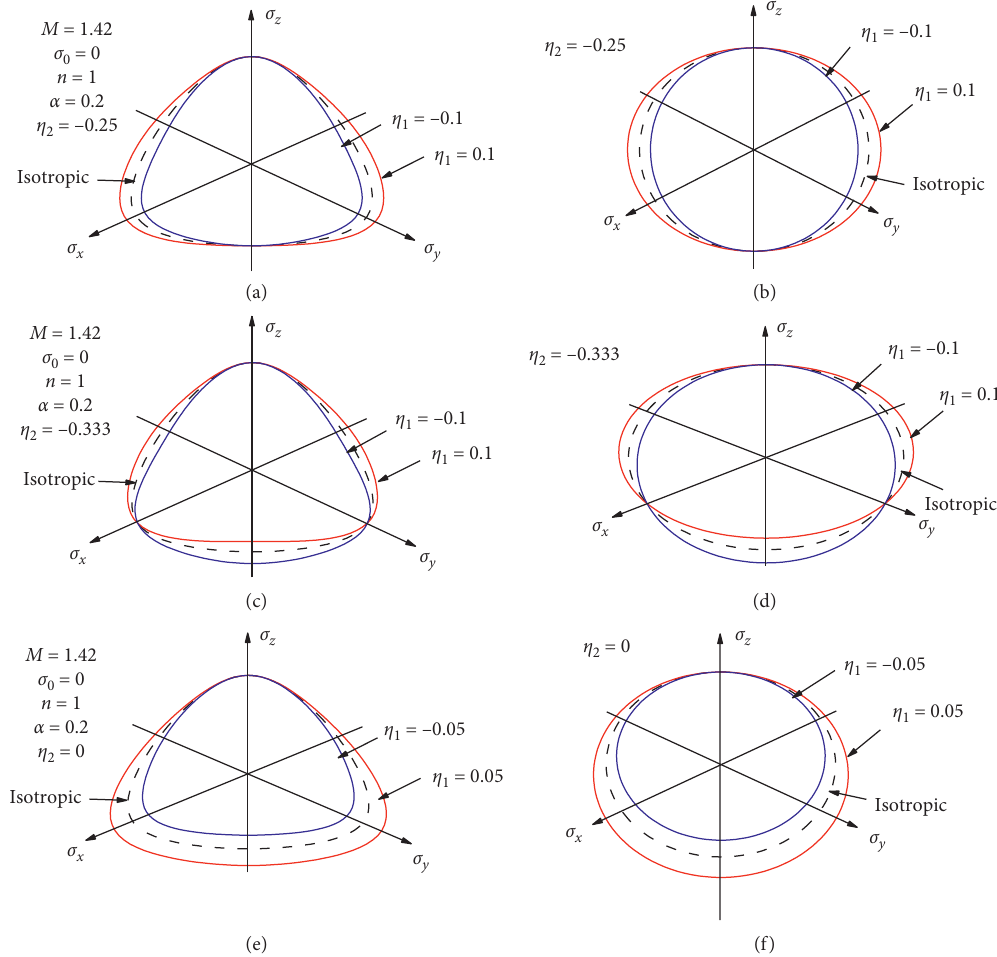
Figure 3: Effect of η 1 on the failure loci and f ( A ) in the deviatoric plane with fixed η 2 in the octahedral plane: (a, c, e) the failure curves and (b, d, f) the f ( A